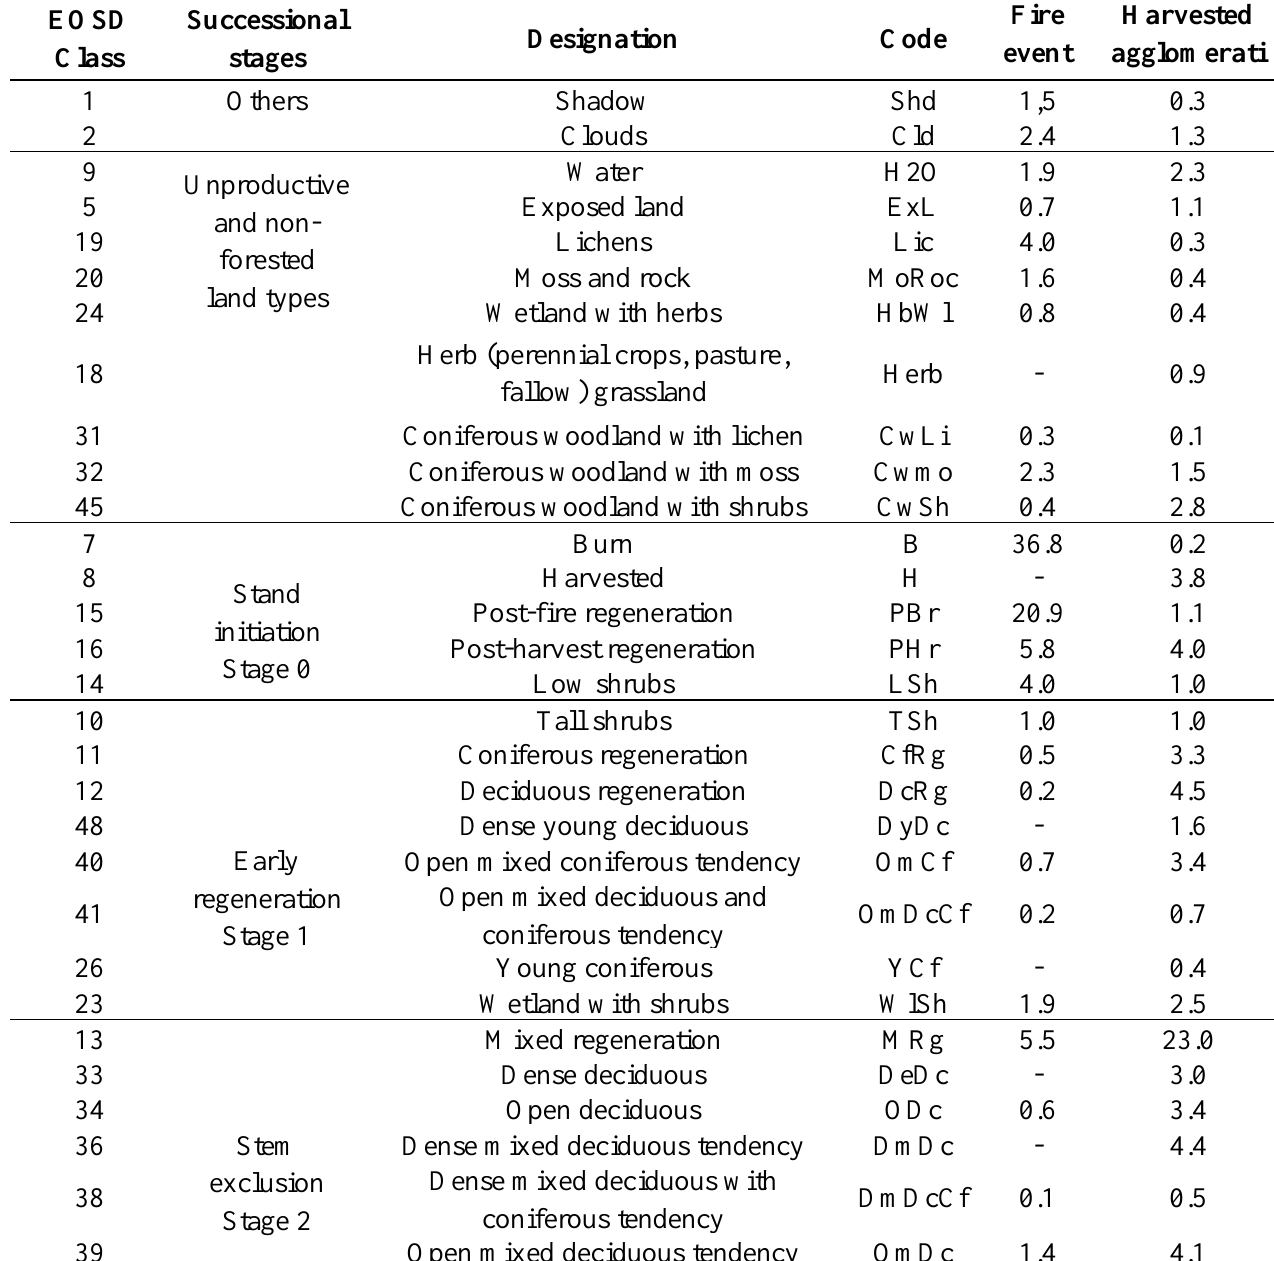
Table A3. Successional stages based on land cover types from satellite imagery and mean relative occupancy (%) of each land cover type by disturbance